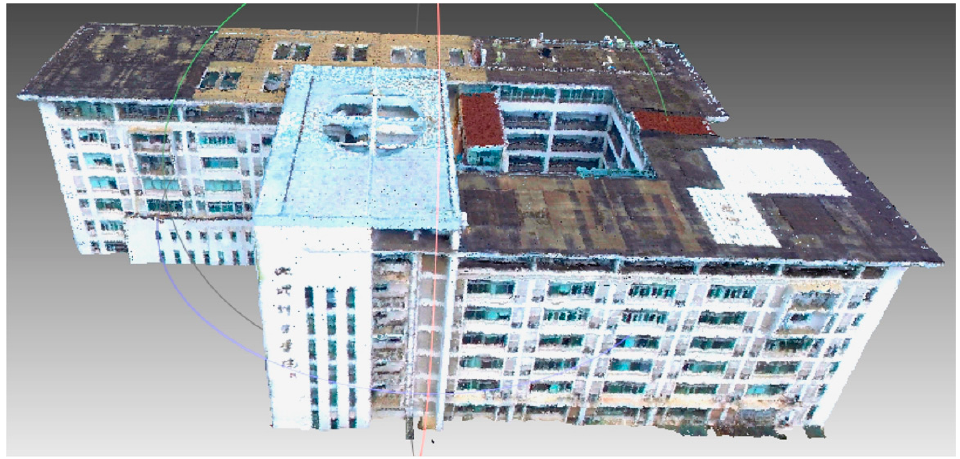
Figure 14. Three-dimensional model of a building.